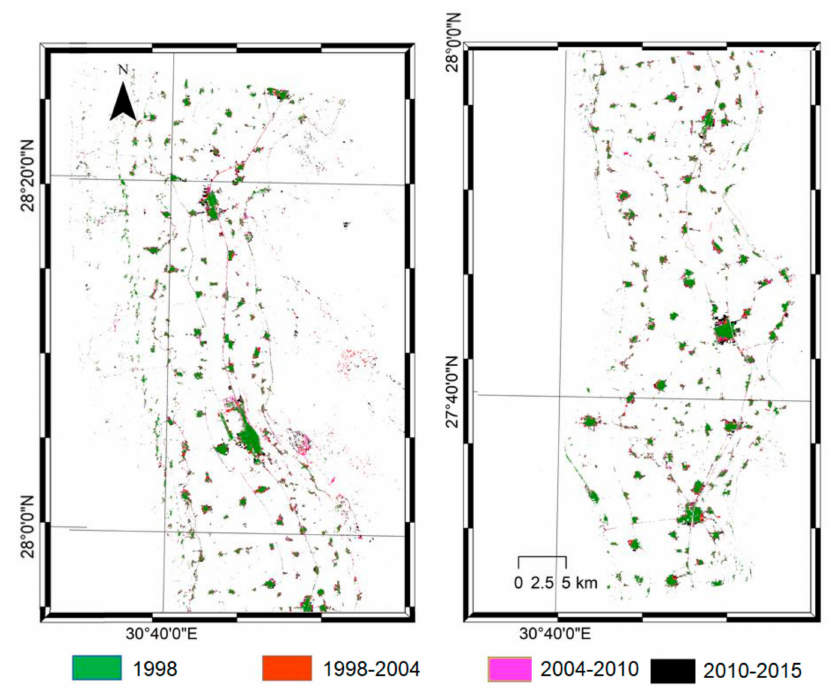
Figure 6. Urban expansion in the study area from 1998 to 2015. Green areas were already urban in 1998 whereas other colours show where urban expansion occurred during the corresponding time period.